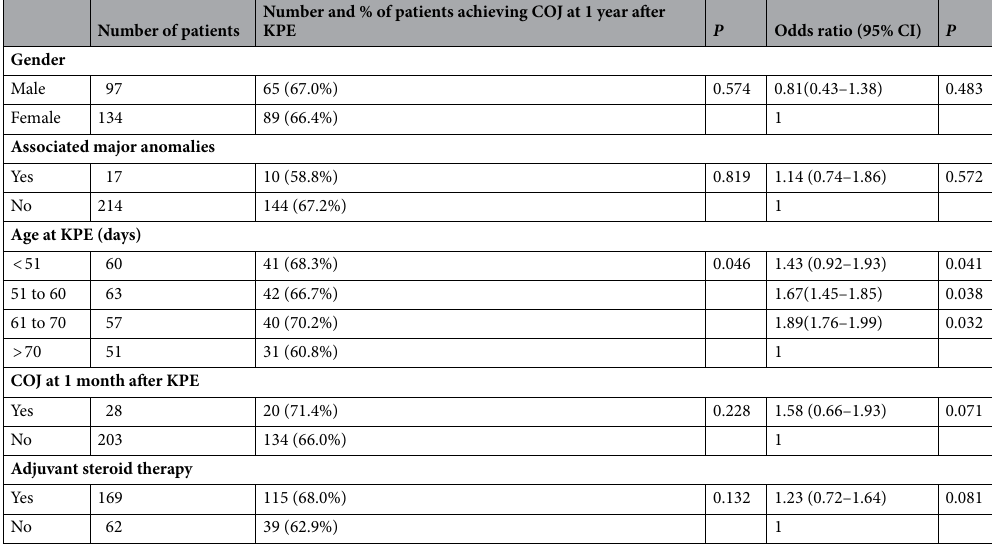
Number of patients